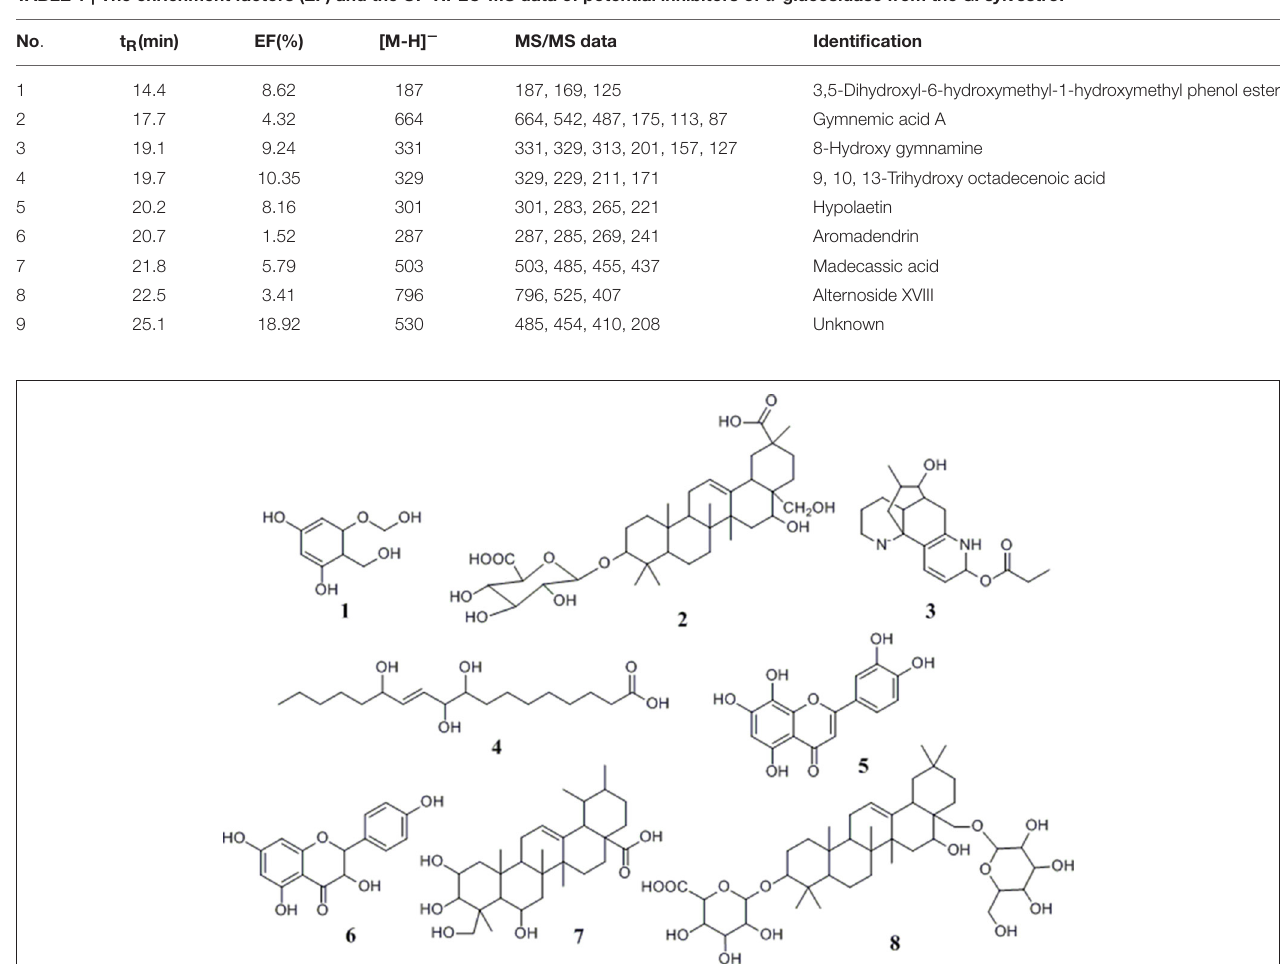
FIGURE 3 | Chemical structures of compounds identified from G. sylvestre based on the MS/MS